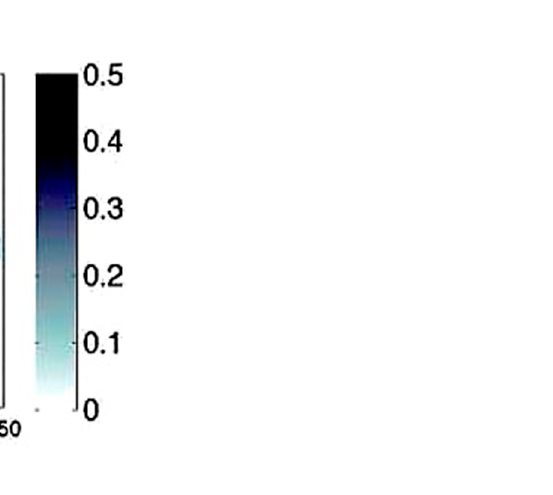
Figure 11. A transect under-hoop after an oil injection. The return from the base of the oil is the dark flat return, and the return from the ice is the lighter color above and to the sides of the oil [66]. Table 5. Predicted operational characteristics of the devices used based on the results of laboratory studies and computer modeling [66].